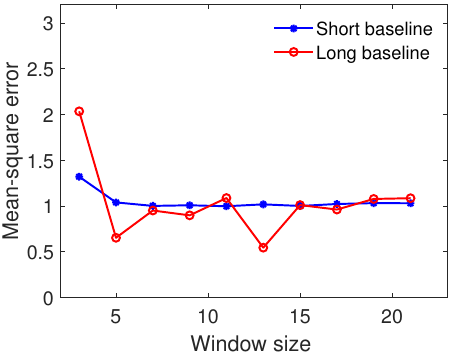
Figure 8. MSE curves of LPM-TSPA method with different window